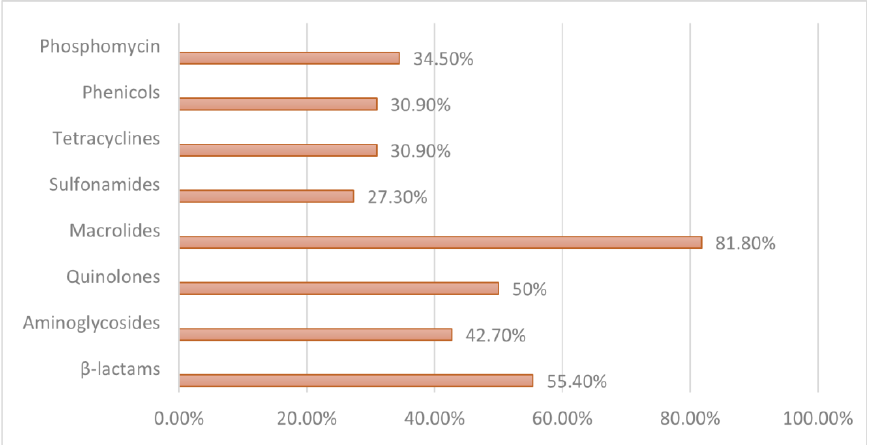
Figure 1. Percentage resistance towards each antimicrobial class. Regarding individual resistance to each antimicrobial, the overall results were ele- vated, with erythromycin (81.8%), ticarcillin-clavulanic acid (80%), and ceftazidime (78.2%) presenting the highest percentages of resistance, while piperacillin-tazobactam and imipenem had the lowest percentage, both with 12.7%. Once more, meropenem and ertapenem, two of the carbapenems tested, presented remarkable percentages of re- sistance (72.7% and 69%, respectively). Figure 2 contemplates the percentage resistance to each antimicrobial tested. Figure 2. Percentage resistance towards each antimicrobial. β -lactam antibiotics tested included penicillins (aminopenicillins, carboxypenicillins, and ureidopenicillins), cephalosporins (1st and 3rd generations), monobactams, and carbapenems, namely amoxicillin (AML 10 ), amoxicillin/clavulanic acid (AMC 30 ); ticarcillin (TIC 75 ), ticarcillin/clavulanic acid (TIM 85 ); piperacillin (PRL 100 ), piperacil- lin/tazobactam (TZP 110 ); cephalothin (KF 30 ); cefoxitin (FOX 30 ); ceftazidime (CAZ 30 ); cefotaxime (CTX 30 ); ceftriaxone (CRO 30 ); cefoperazone (CFP 30 ); aztreonam (ATM 30 ); imipenem (IMP 10 ), mero- penem (MEM 10 ), and ertapenem (ETP 10 ) — dark blue box. Quinolones (nalidixic acid — (NA 30 )/quin- olone, ciprofloxacin — (CIP 5 )/fluroquinolone) — yellow box. Aminoglycosides (kanamycin (K 30 ); to- bramycin (TOB 10 ); gentamicin (CN 10 ); amikacin (AK 30 )) — green box. Macrolides (erythromycin (E 15 )